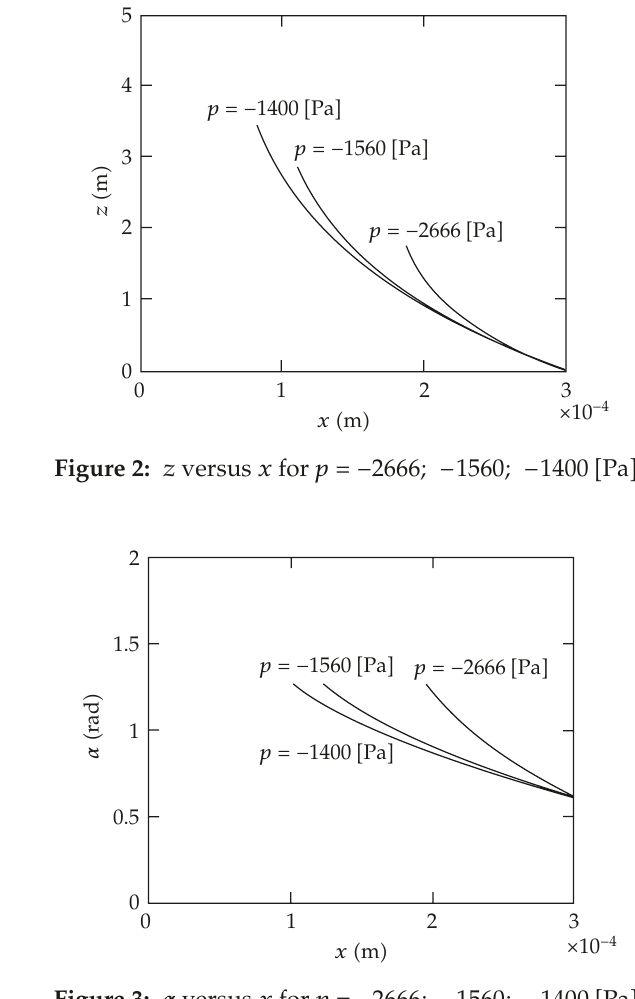
Figure 3: α versus x for p (cid:8) − 2666; − 1560; − 1400 (cid:6) Pa (cid:7)